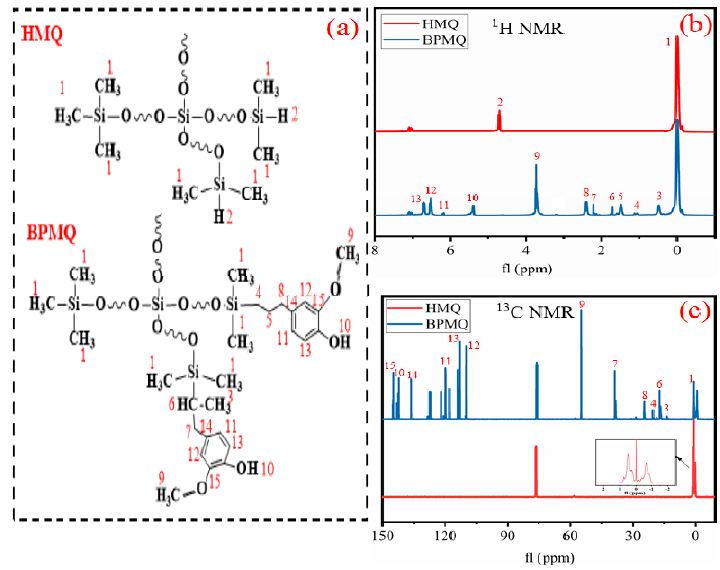
Figure 3. 1 H NMR and 13 C NMR spectroscopic analysis. ( a ) Molecular formula of HMQ and BPMQ; ( b ) 1 H NMR spectrum of HMQ and BPMQ; ( c ) 13 C NMR spectrum of HMQ and BPMQ.